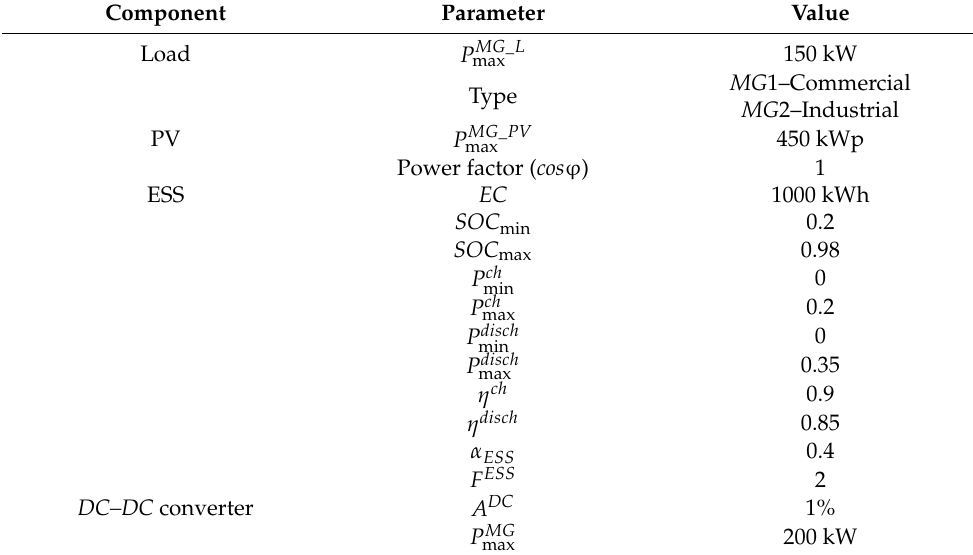
Table 3. Basic parameters for the DC -microgrids